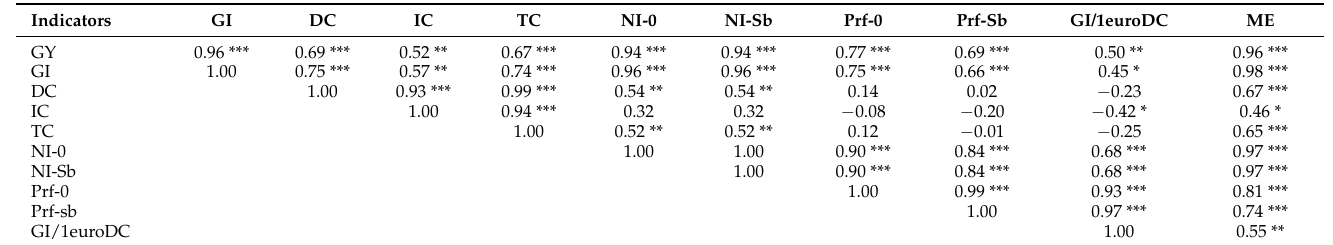
Table A2. Correlation matrix of basic economic indices of winter wheat and grain yield, 2015 costs, n = 28.